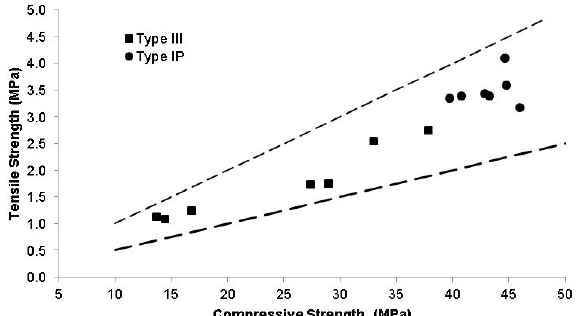
Figure 9. Relationship between tensile strength and compressive strength of concretes.